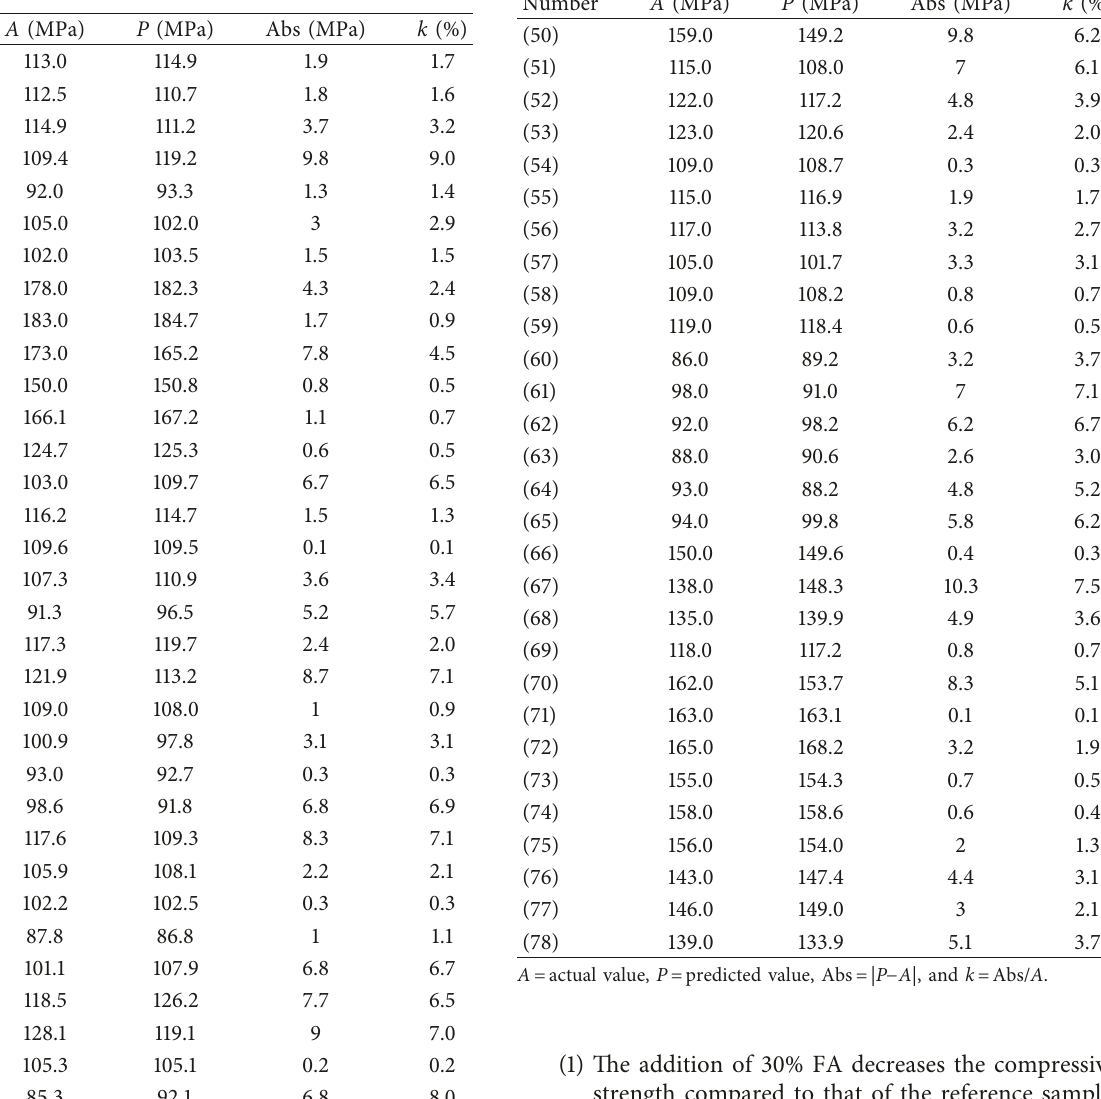
Table 5: Comparison between the predicted and experimental